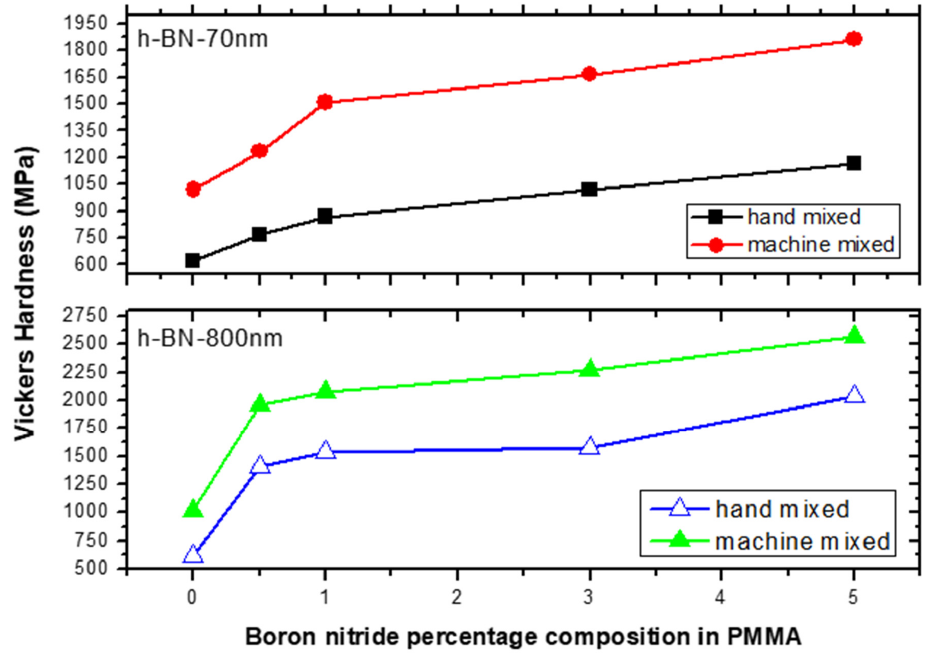
Figure 9. Vickers hardness (VH) measurements versus h-BN composition in PMMA on specimens made by hand and ultrasonic mixing methods.